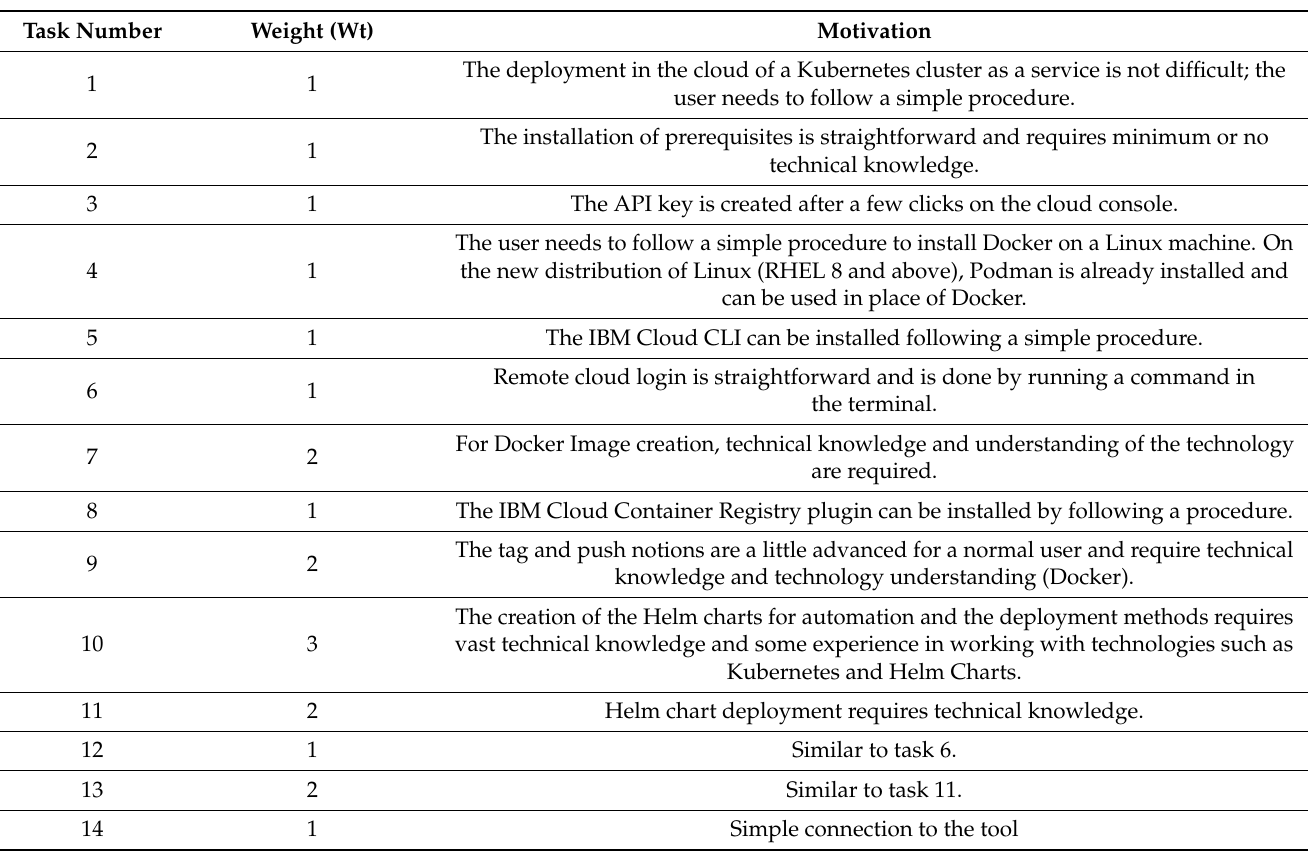
Figure 4. The weighted automated deployment process. Table 8. Weights for the manual deployment